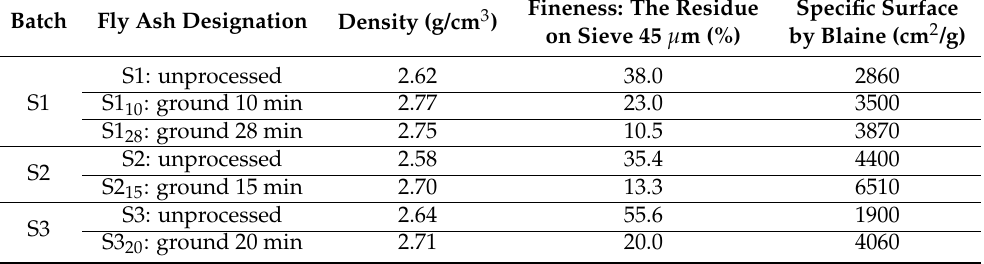
Table 2. Physical properties of high calcium fly ashes before and after processing [19].